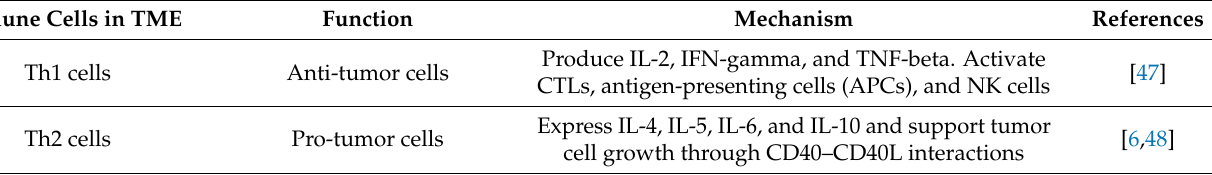
Table 1. Immune cells in tumor microenvironment of lymphoproliferative diseases. Immune Cells in